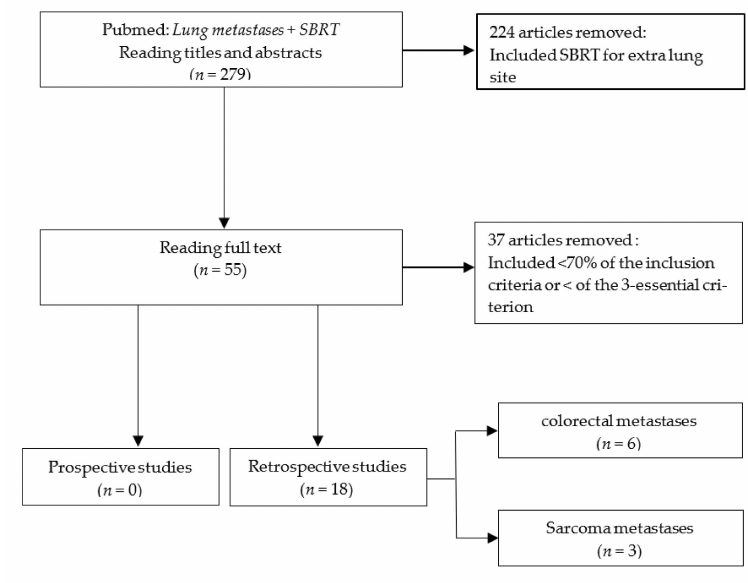
Figure 1. Flowchart of published selected